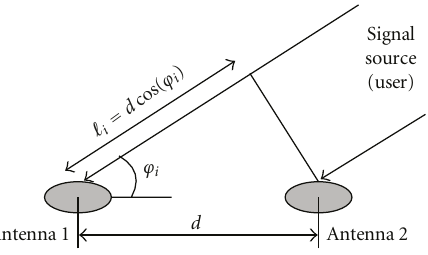
Figure 1: AOA measurement at an array antenna.